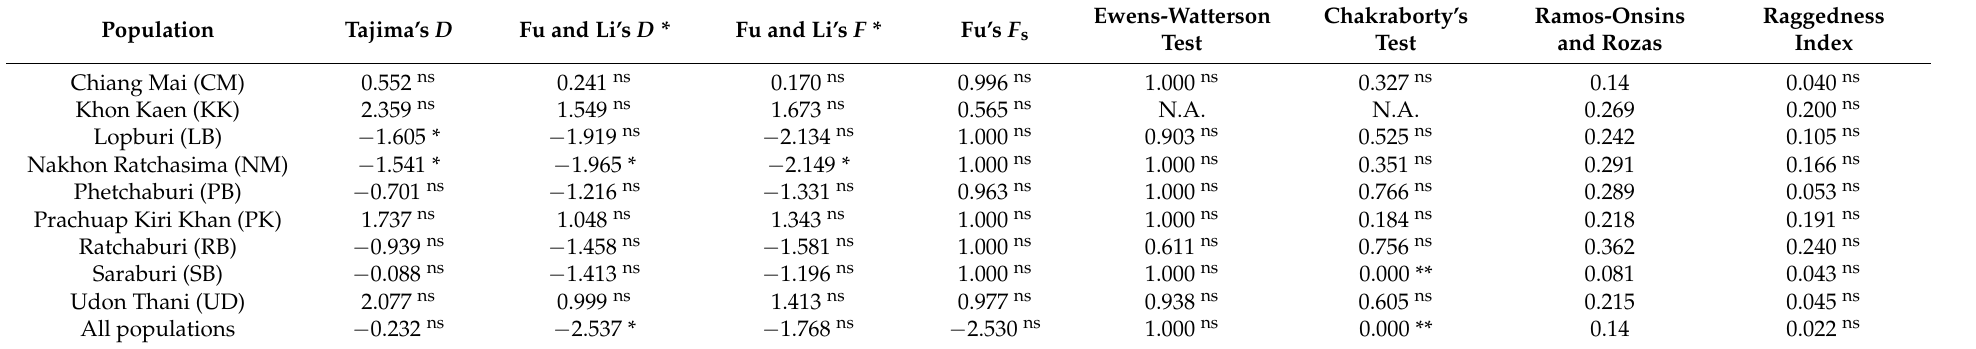
Table 4. Neutrality tests of mitochondrial D-loop sequences from nine cattle populations in